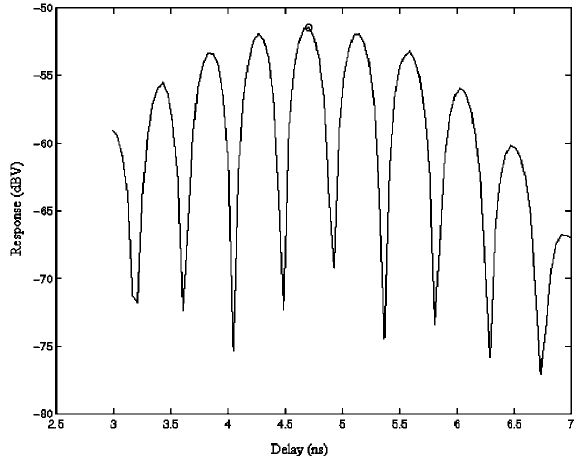
FIG. 6. Longitudinal back-end response (dBV) versus BE programmable delay (ns).